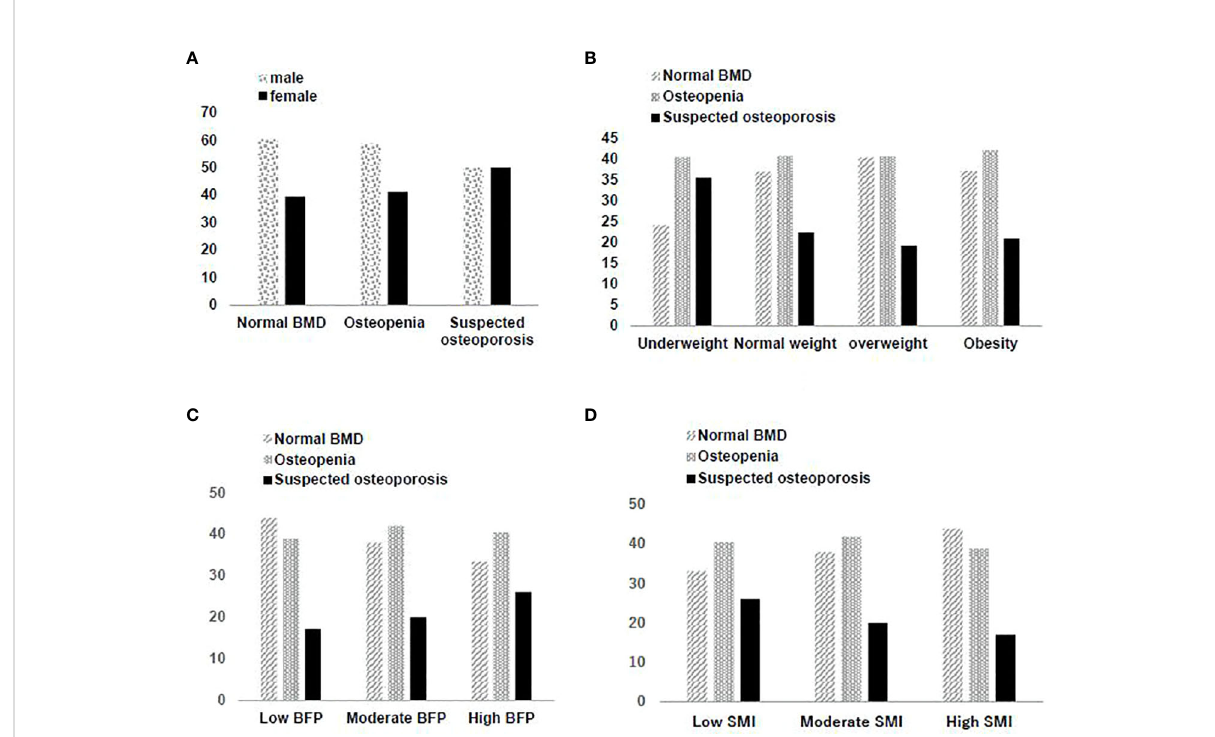
FIGURE 2 (A) Gender distribution in different bone mineral density screening results. (B) Distribution of bone mineral density screening results in different BMI groups. (C) Distribution of bone mineral density screening results in different BFP groups. (D) Distribution of bone mineral density screening results in different SMI